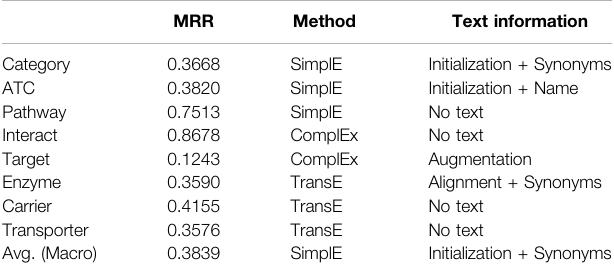
TABLE 5 | Summary of the best settings for each